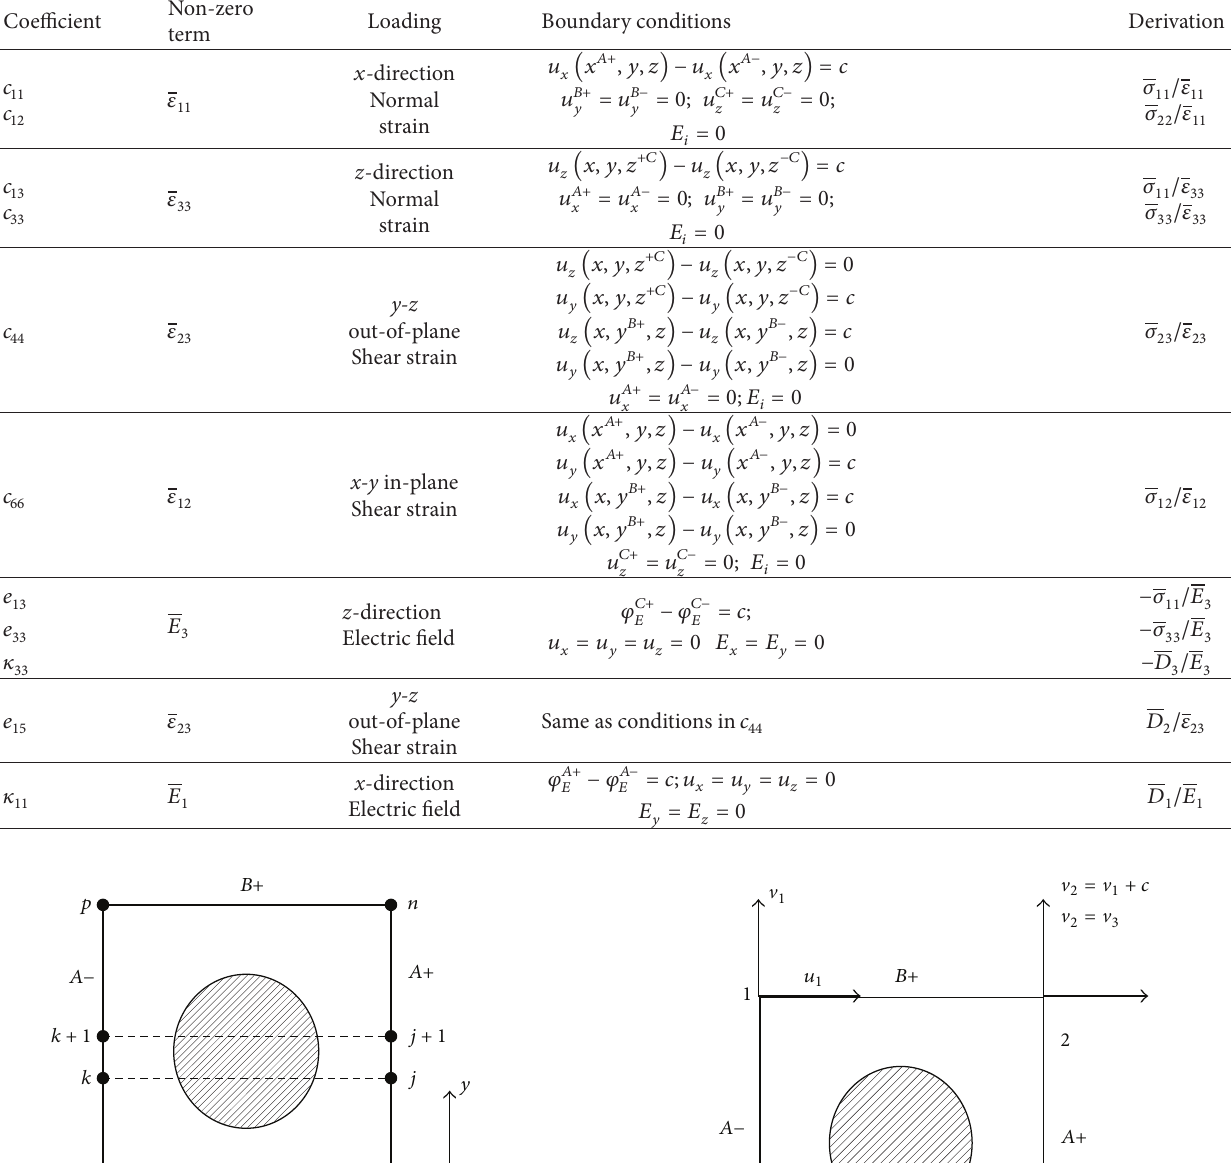
Table 2: Summary of the numerical calculation of coefficients.